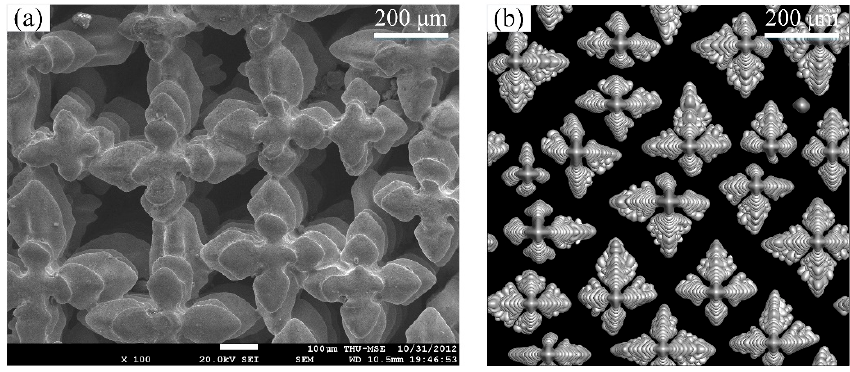
Figure 11. Top view of the ( a ) SEM image and ( b ) phase-field simulation result of the primary dendrite arms in HRS directional solidification process.